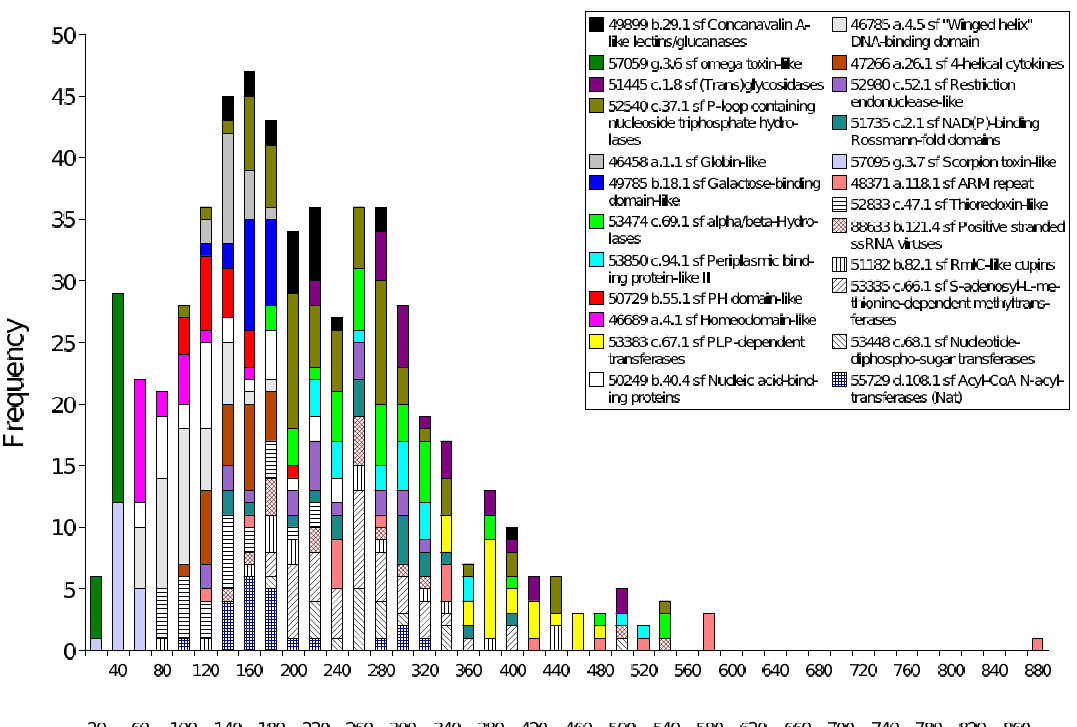
Figure 3: Sequence length of domains in superfamilies from Astral20 that contain > 15 domains (excluding multi domain proteins). The length is grouped into bins of 20 amino acids. This figure highlights the clustering of superfamilies by the length of the domains within them. The Importin beta domain (d1qgra a.118.1.1) from the ARM repeat superfamily (48371 a.118.1 sf) is the longest domain (877